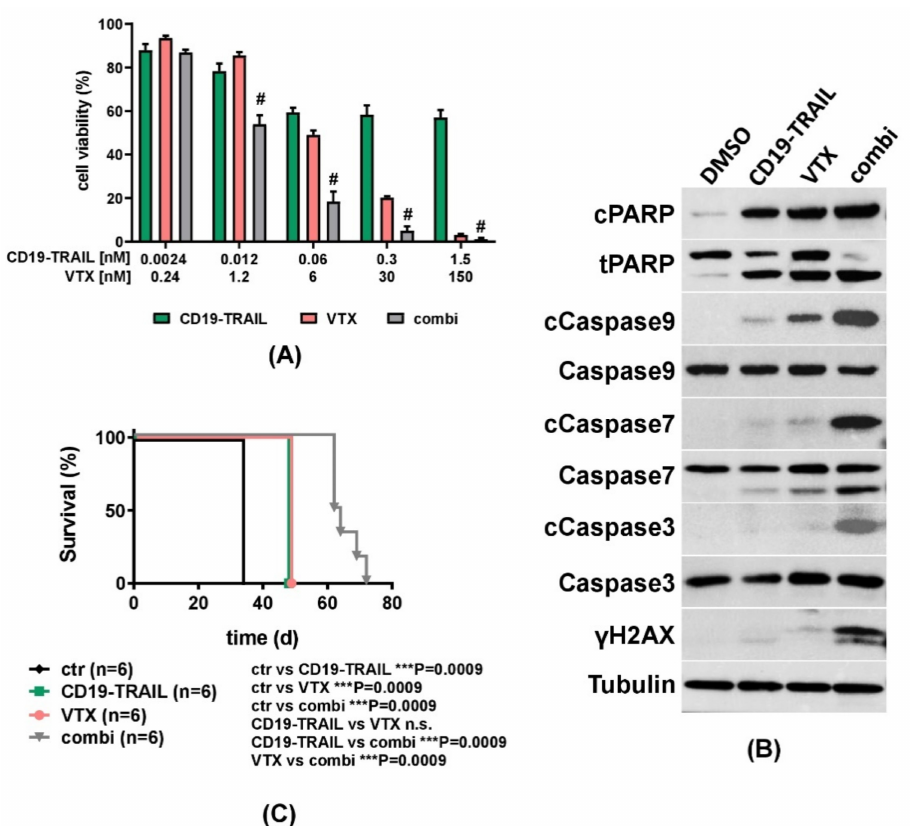
Figure 5. ALL-killing effect of CD19-TRAIL is synergistically enhanced by Venetoclax: ( A ) REH cells were treated with escalating concentrations of CD19-TRAIL, the BCL-2 inhibitor Venetoclax (VTX), or the combination of both (combi). Cell viability was determined by MTT assay after 72 h. Combination Index (CI) was calculated via CompuSyn Software, and synergism (CI < 1) is indicated by (#). Values for CI calculations are noted in Supplementary Figure S4. Data represent mean values ± SEM of n = 3 independent experiments; ( B ) Representative western blot analyses of REH cells treated with DMSO, CD19-TRAIL (0.06 nM), VTX (6 nM), or the combination (combi) for 48 h. Expression levels of indicated proteins were determined in whole-cell protein extracts. Tubulin served as a loading control; ( C ) Female NSG-mice were intravenously injected with 0.5 × 10 6 REH cells ( n = 6 per group) and treated with 1.5 mg/kg of CD19-TRAIL intravenously on days +1, +3, +6, +10, +13 and every 7 days thereafter; 100 mg/kg VTX daily oral gavage; or both (combi). Untreated mice served as control (ctr). When showing signs of overt leukemia (clinical signs of leukemia including loss of weight or activity, organomegaly, hind-limb paralysis), mice were euthanized, and differences in mouse survival were calculated using Kaplan–Meier log-rank test, *** p <